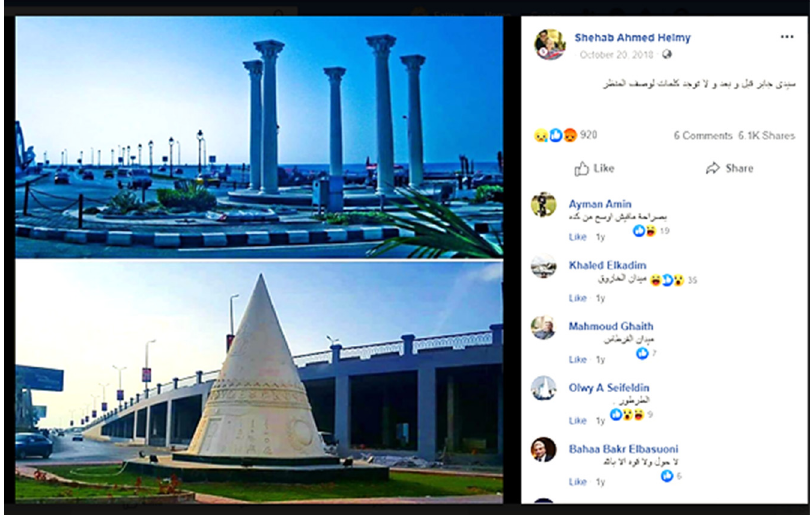
Figure 6. A screenshot of one of the Facebook group comments about these two photographs with the same angle of view. The main comment by Shehab Ahmed Helmy says, ‘The area before and after, and no words can describe this scene’. Source: F.